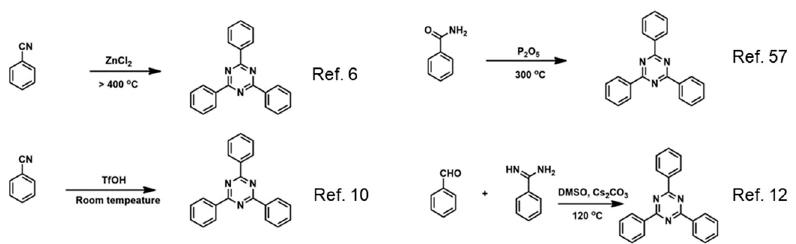
Figure 2. Typical reactions for the synthesis of CTFs.